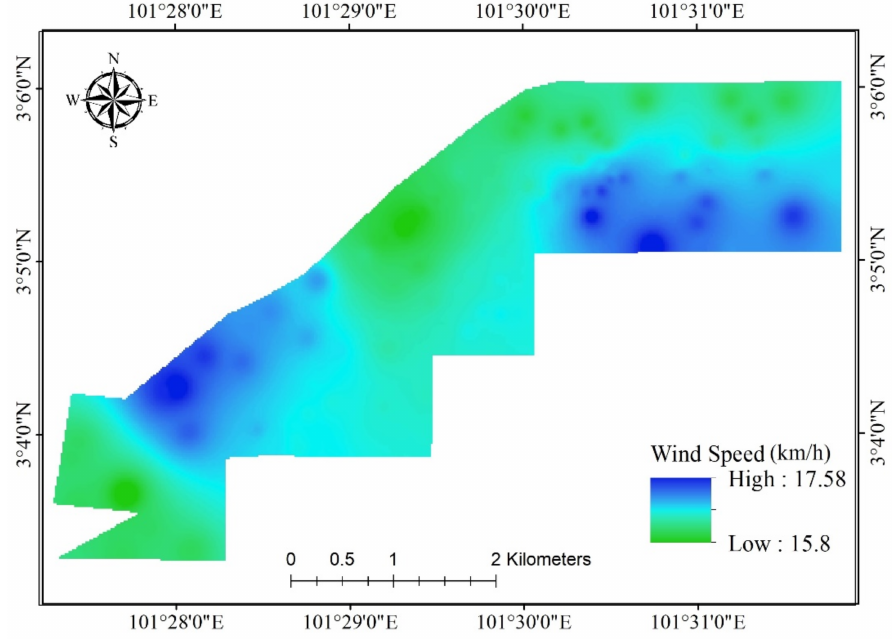
Figure 7. Wind speed